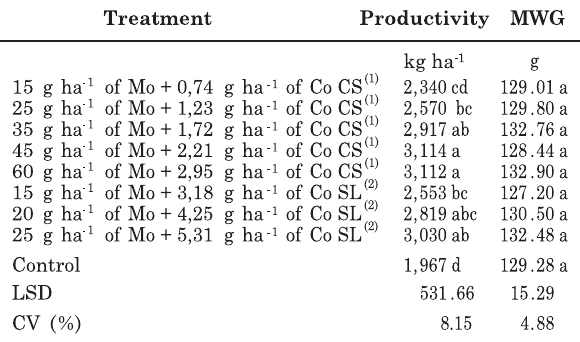
Figure 2. Soybean yield as related to seed treatments with Mo and Co doses in liquid solution in 2005/ 2006. Table 3. Mean leaf nitrogen and micronutrients in soybean after application of different Mo and Co doses in concentrated suspension and liquid solution in